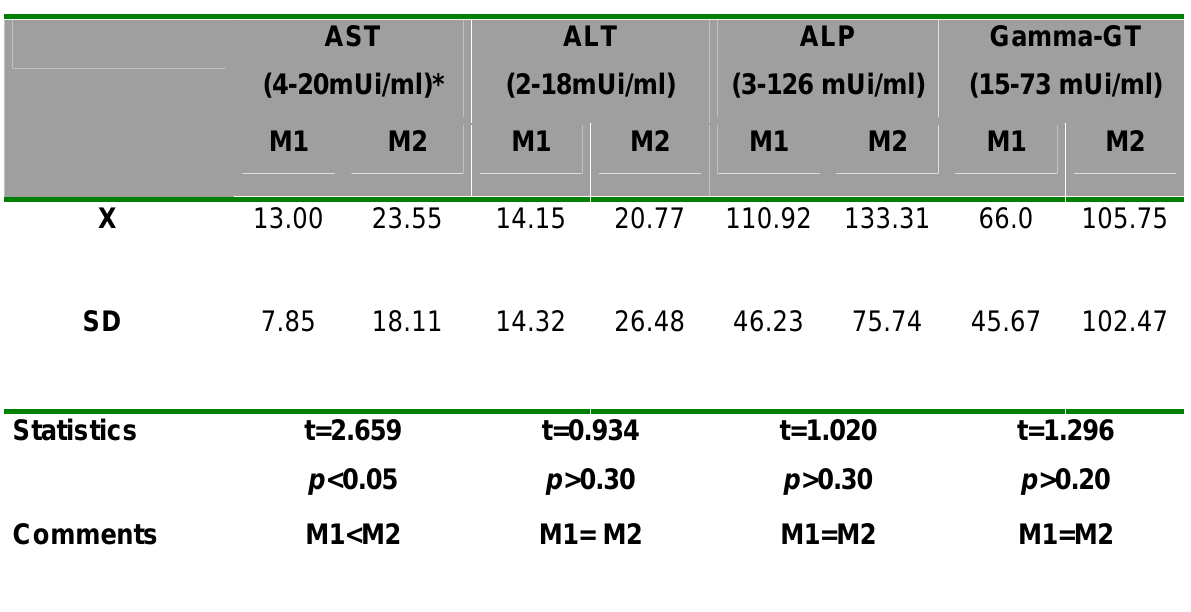
Table 2: Serum biochemical parameters (X±SD) of patients with pulmonary tuberculosis at both study moments (M1, before triple treatment; M2, two months after treatment initiation).